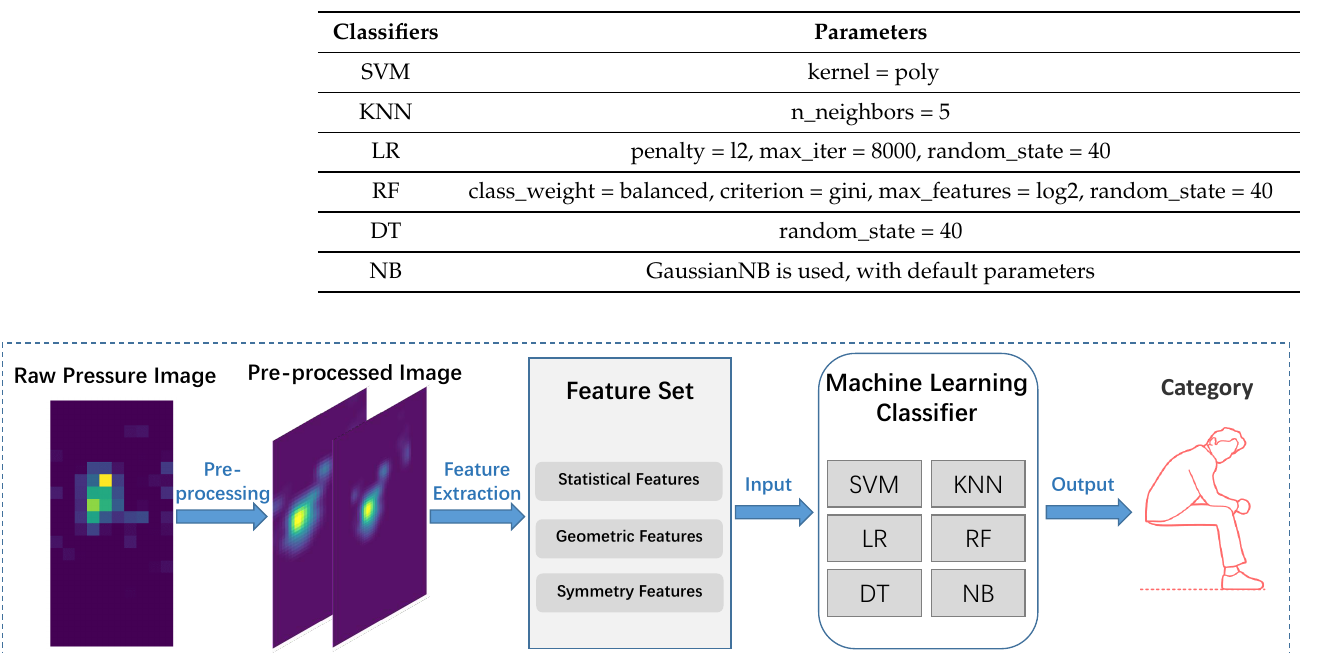
Table 4. The specified parameters for classical classifiers.